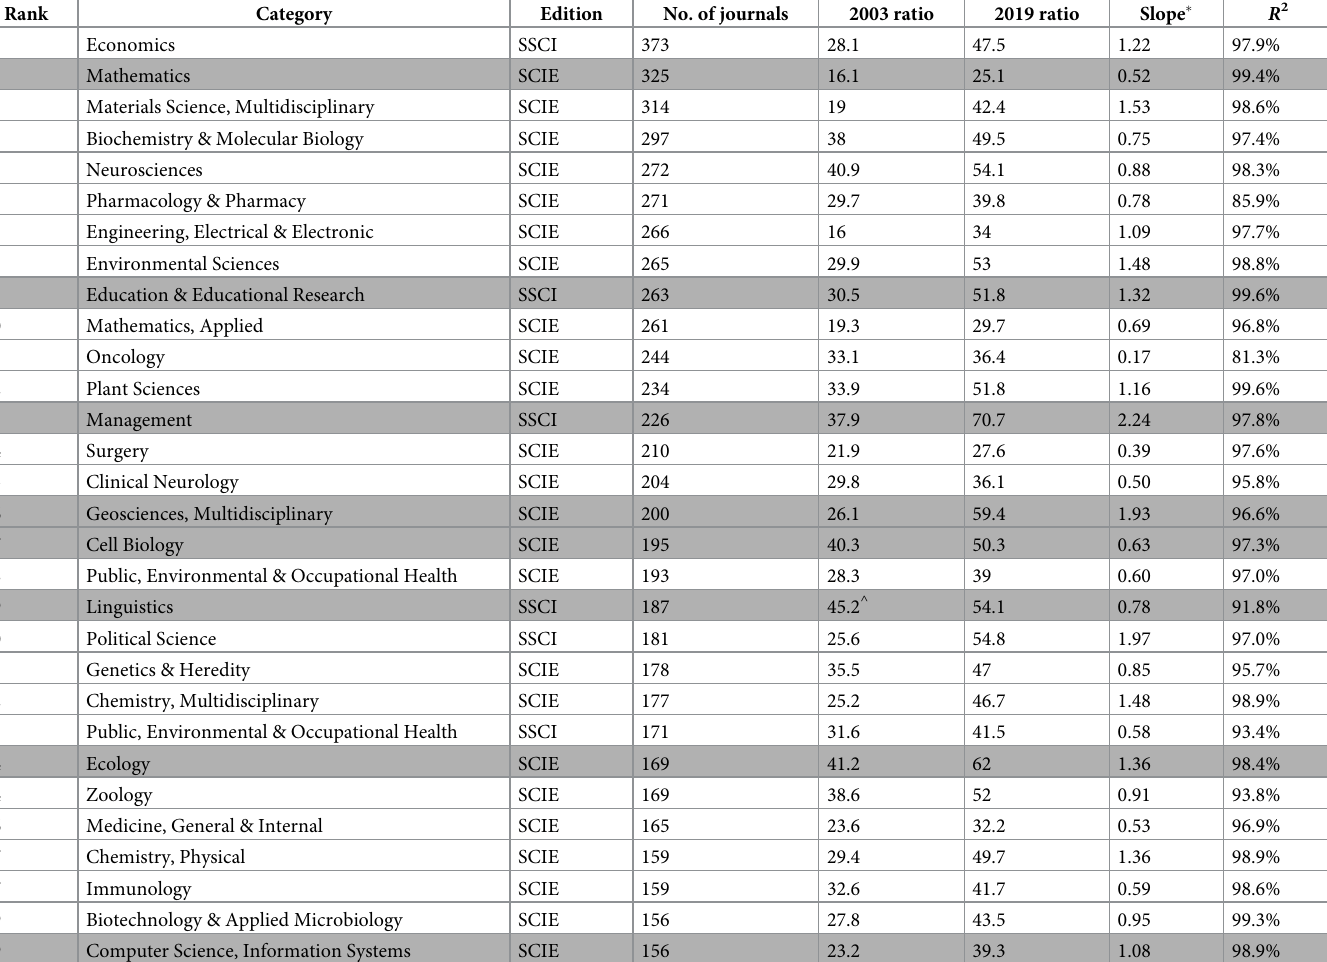
Table 1. Reference density (ratio) in 2003 (start point) and 2019 (end point) of the top 30 disciplinary categories included in Journal Citation Reports for year